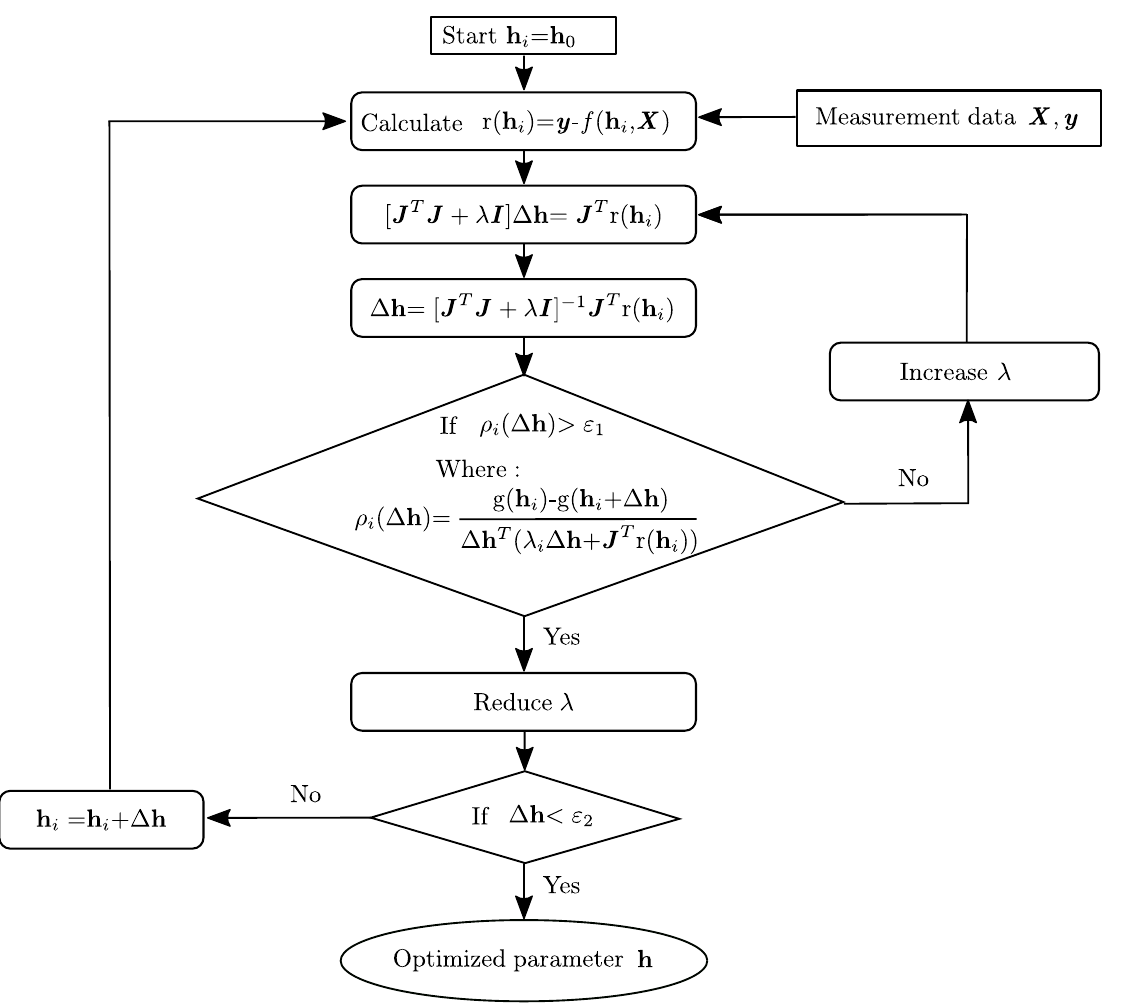
Figure 1. Flow chart of the Levenberg–Marquardt fitting algorithm.